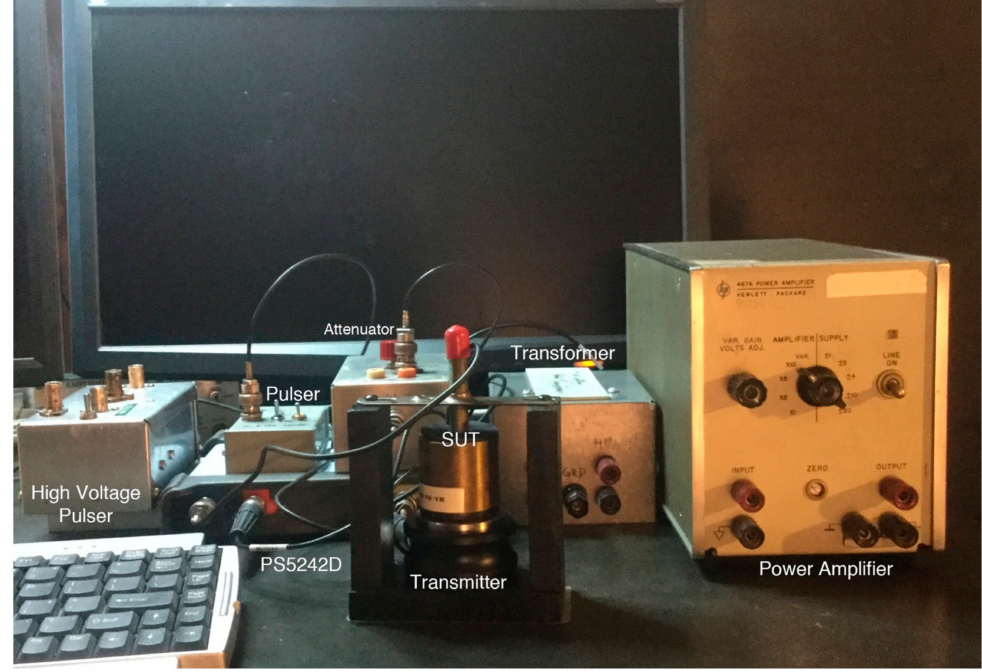
Figure 5. A photograph of the face-to-face test